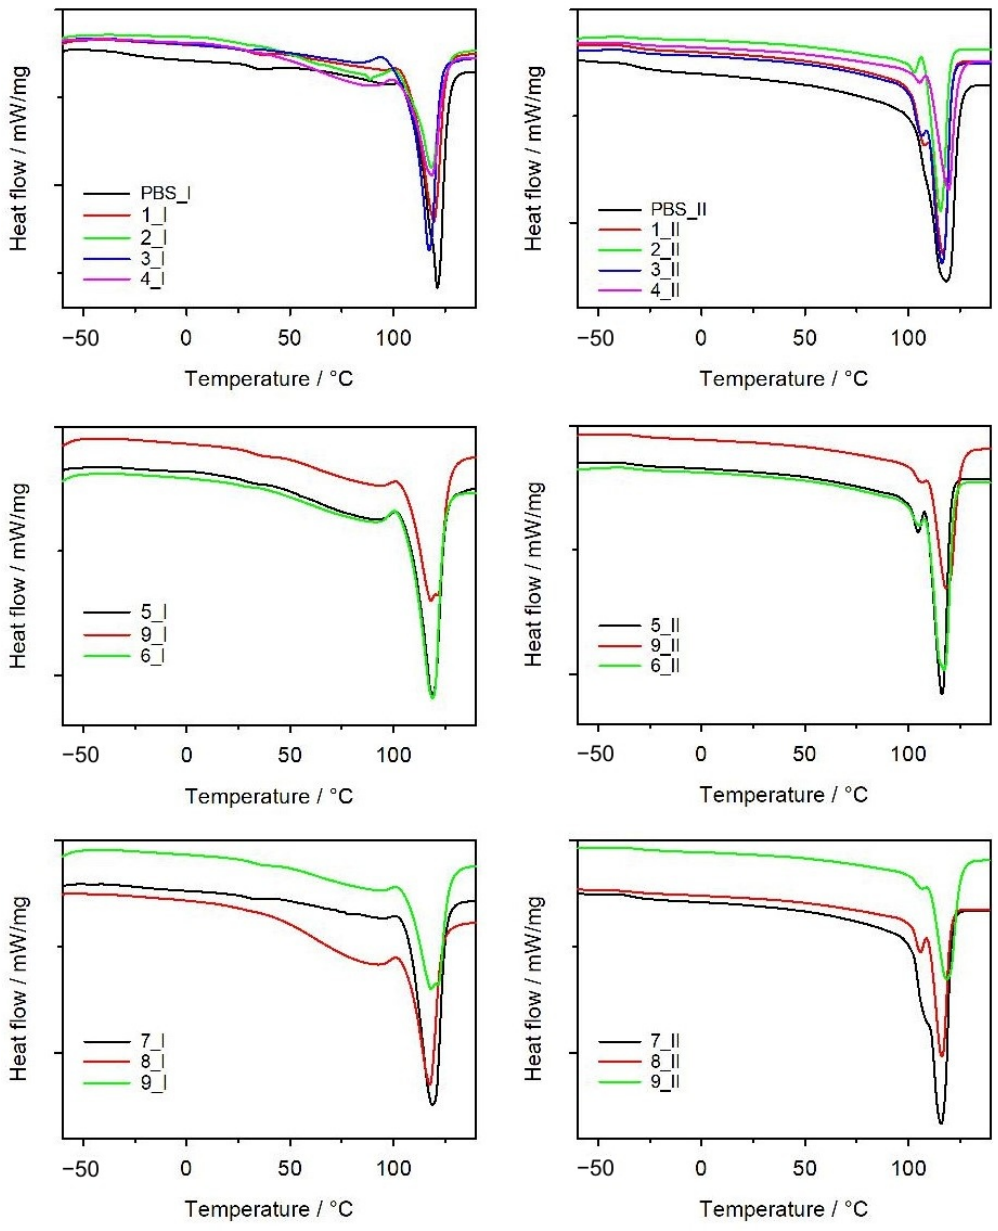
Figure 10. DSC thermograms of first (I) and second (II) heating scans of neat PBS and its composites with bran (exo up).